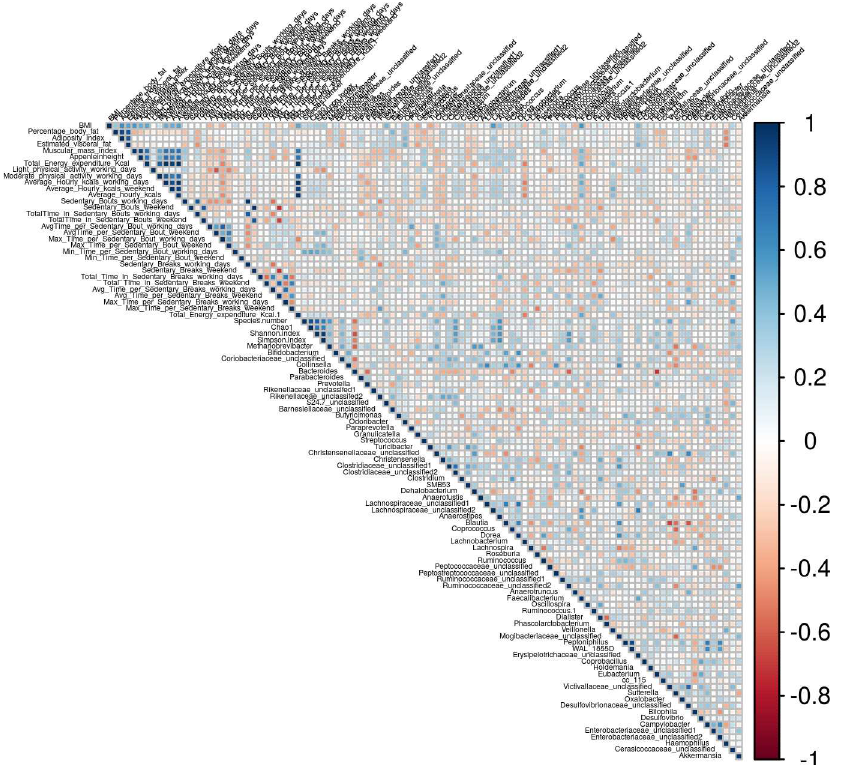
Fig 5. Spearman correlation of microbiota genera, body composition and physical activity parameters.